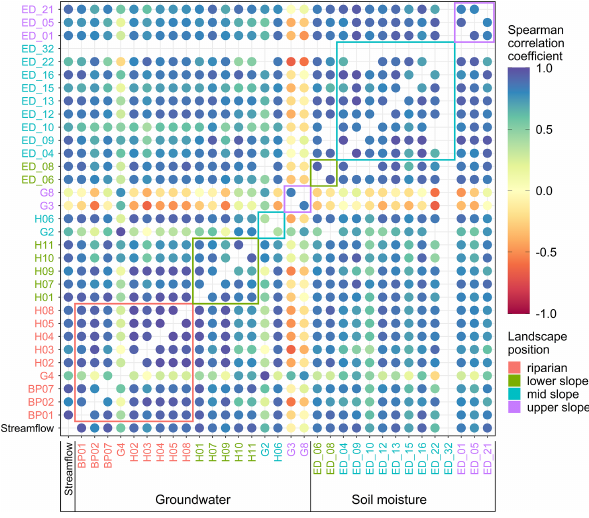
Figure 13. Median Spearman correlation coefficient between me- dian weekly streamflow at catchment outlet ( Q ), groundwater (BP ∗∗ , H ∗∗ , G ∗ ) and soil moisture (ED_ ∗∗ ) over years 2017 and 2018. Circles’ colour corresponds to the value of the Spearman correlation coefficient. The station names’ colour corresponds to their landscape unit. Coloured rectangles enclose values of stations in the same landscape unit. Only time series longer than 45 weeks per year are